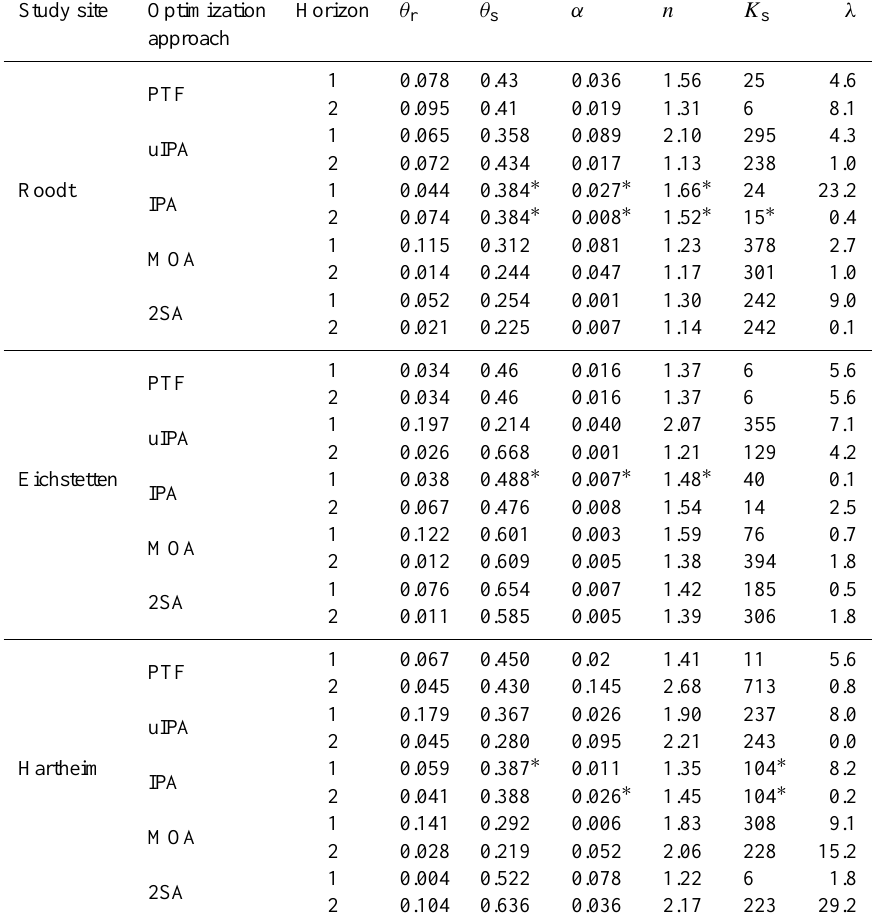
Table 4. Best-performing parameter sets of the different optimization approaches for the three different study sites. ∗ indicate parameter that reached the initial boundaries of the parameter space in the